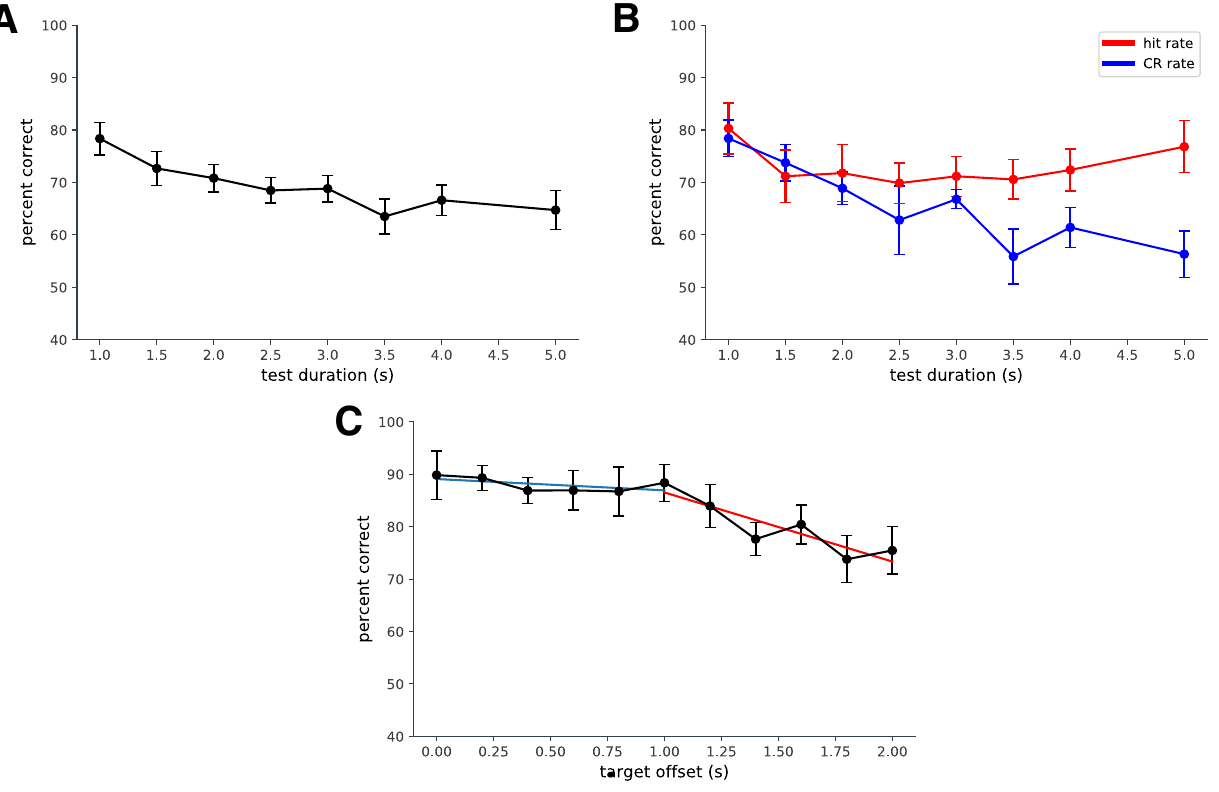
Figure 4. ( A ) Experiment 5: the effects of distractors and target position in a yes-no task (only one test sequence was presented on each trial). Detection accuracy is shown for a 1 s target within test clips of up to 5 s in length. ( B ) The same data as in ( A ), plotted separately for hits and correct rejections. The reduction in performance with test length is mainly due to a drop in correct rejections, rather than a drop in hit rate. ( C ) Experiment 6: we varied the position of a 1 s target within a 3 s test sequence. Later targets are detected less